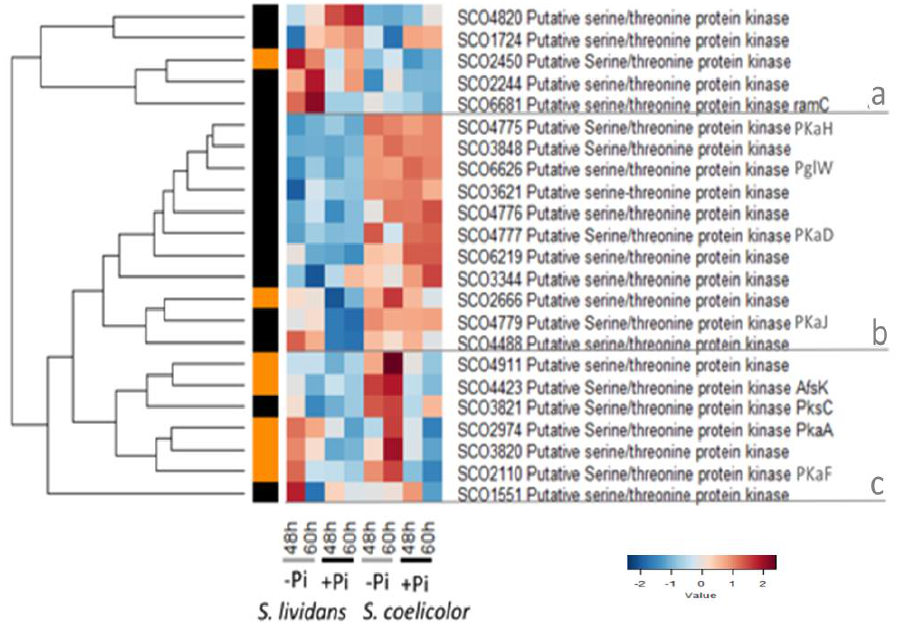
Figure 10. Heatmap representation of the abundance of eukaryotic-like serine or threonine protein kinases in SL and SC that can be divided in 3 sub-clusters, a, b and c. The 5 proteins of cluster a were more abundant in SL than in SC in Pi proficiency or limitation. The 11 proteins of cluster b were more abundant in SC than in SL in both Pi conditions. The 7 proteins of cluster c were more abundant in SC than in SL in Pi limitation at both time points but 4 of these proteins were also abundant in Pi limitation, in SL at 48 h.